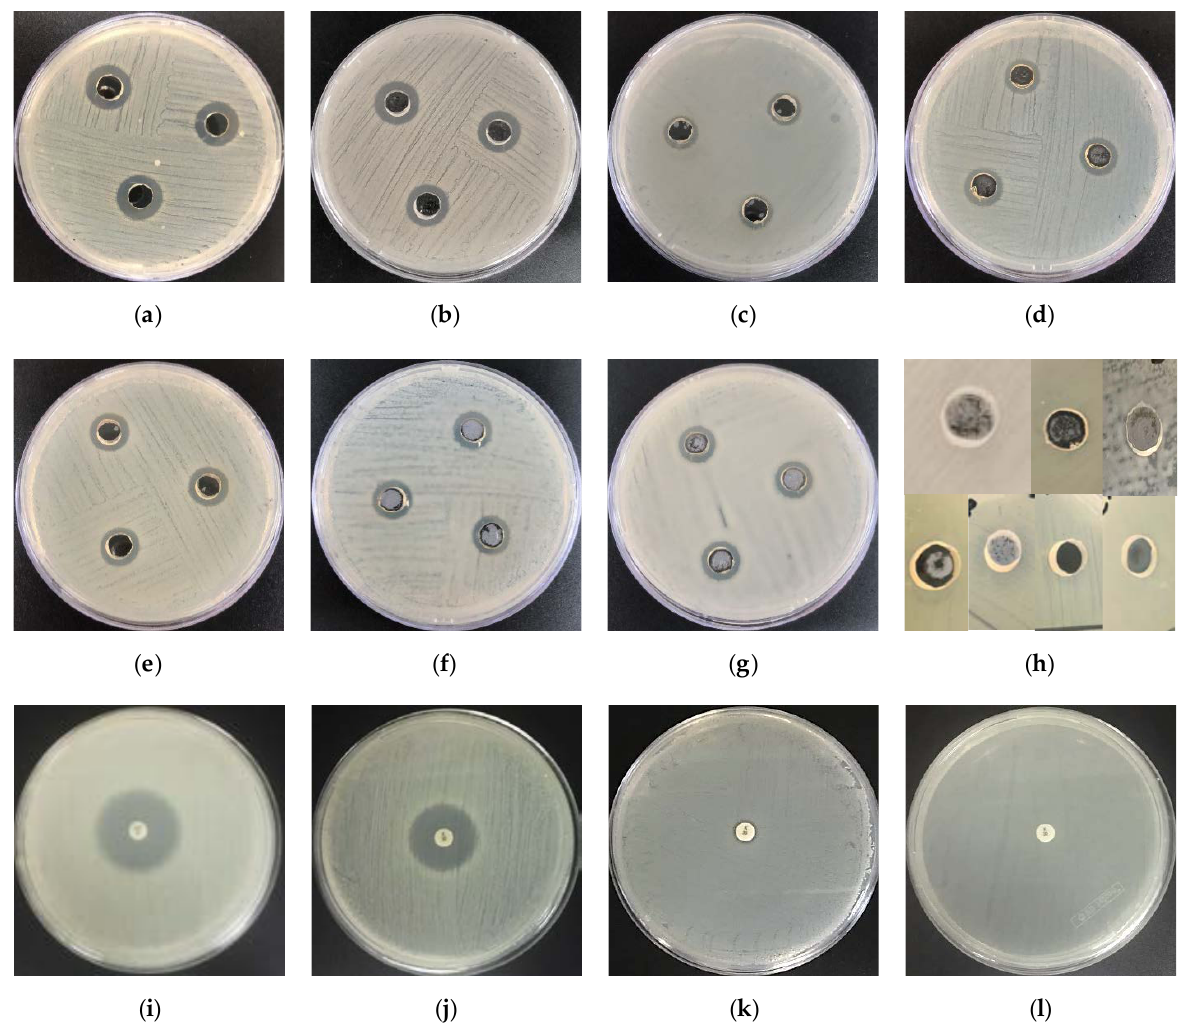
Figure 7. The inhibition zones of C-AgNPs against ( a ) MRSA , ( b ) S. aureus , ( c ) E. faecalis , ( d ) E. coli , ( e ) S. typhimurium , ( f ) K. pneumoniae , and ( g ) P. aeruginosa , and in ( h ) Cascabela thevetia aqueous leaf extract antibacterial activity test against the same seven bacterial pathogens. The zones of inhibition formed by Ciprofloxacin and Kanamycin against MRSA are shown in ( i ) and ( j ), respectively, whereas Kanamycin's ineffectiveness against K. pneumoniae and P. aeruginosa are demonstrated in ( k ) and ( l ), separately. Table 1. The estimation of the zone of inhibition diameters formed by C-AgNPs against the tested bacterial and fungal pathogens.